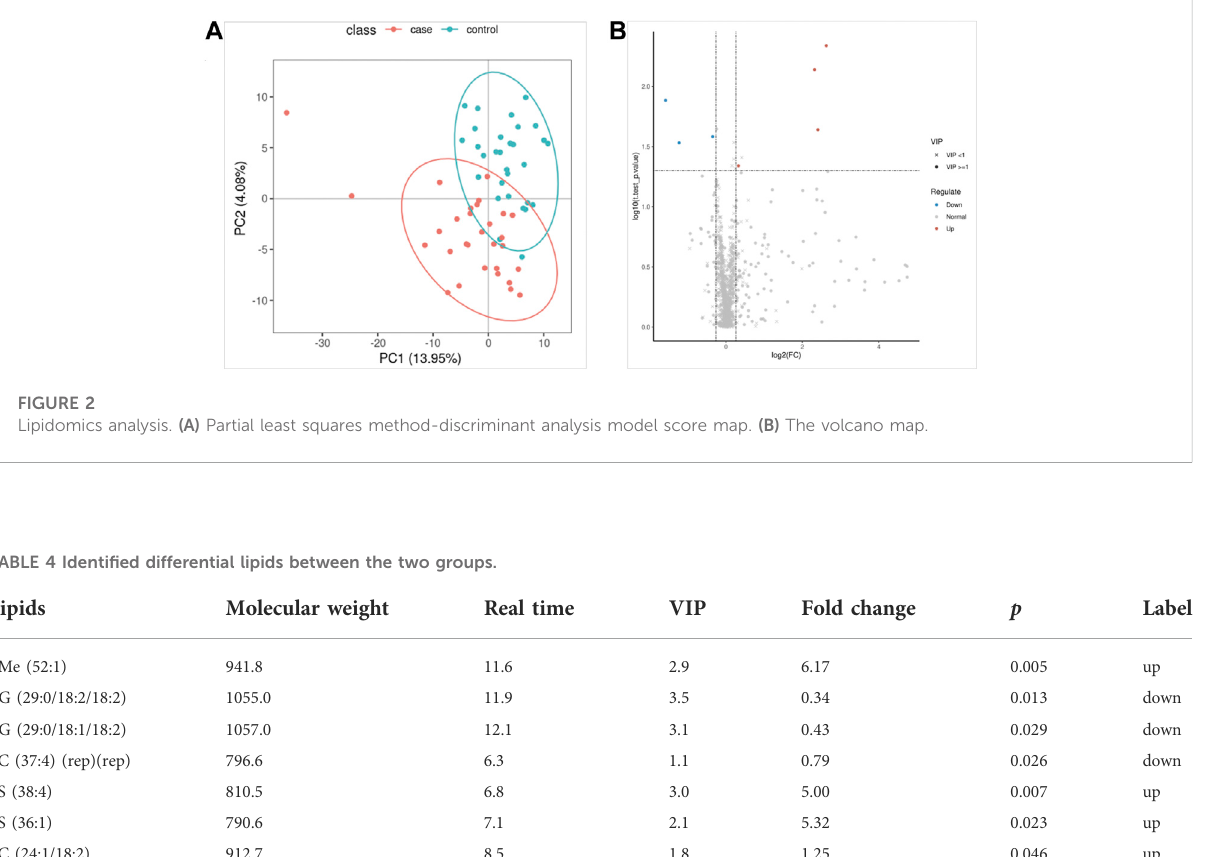
TABLE 5 Enrichment table of metabolic pathways for differential lipids. Pathway Count Count all p